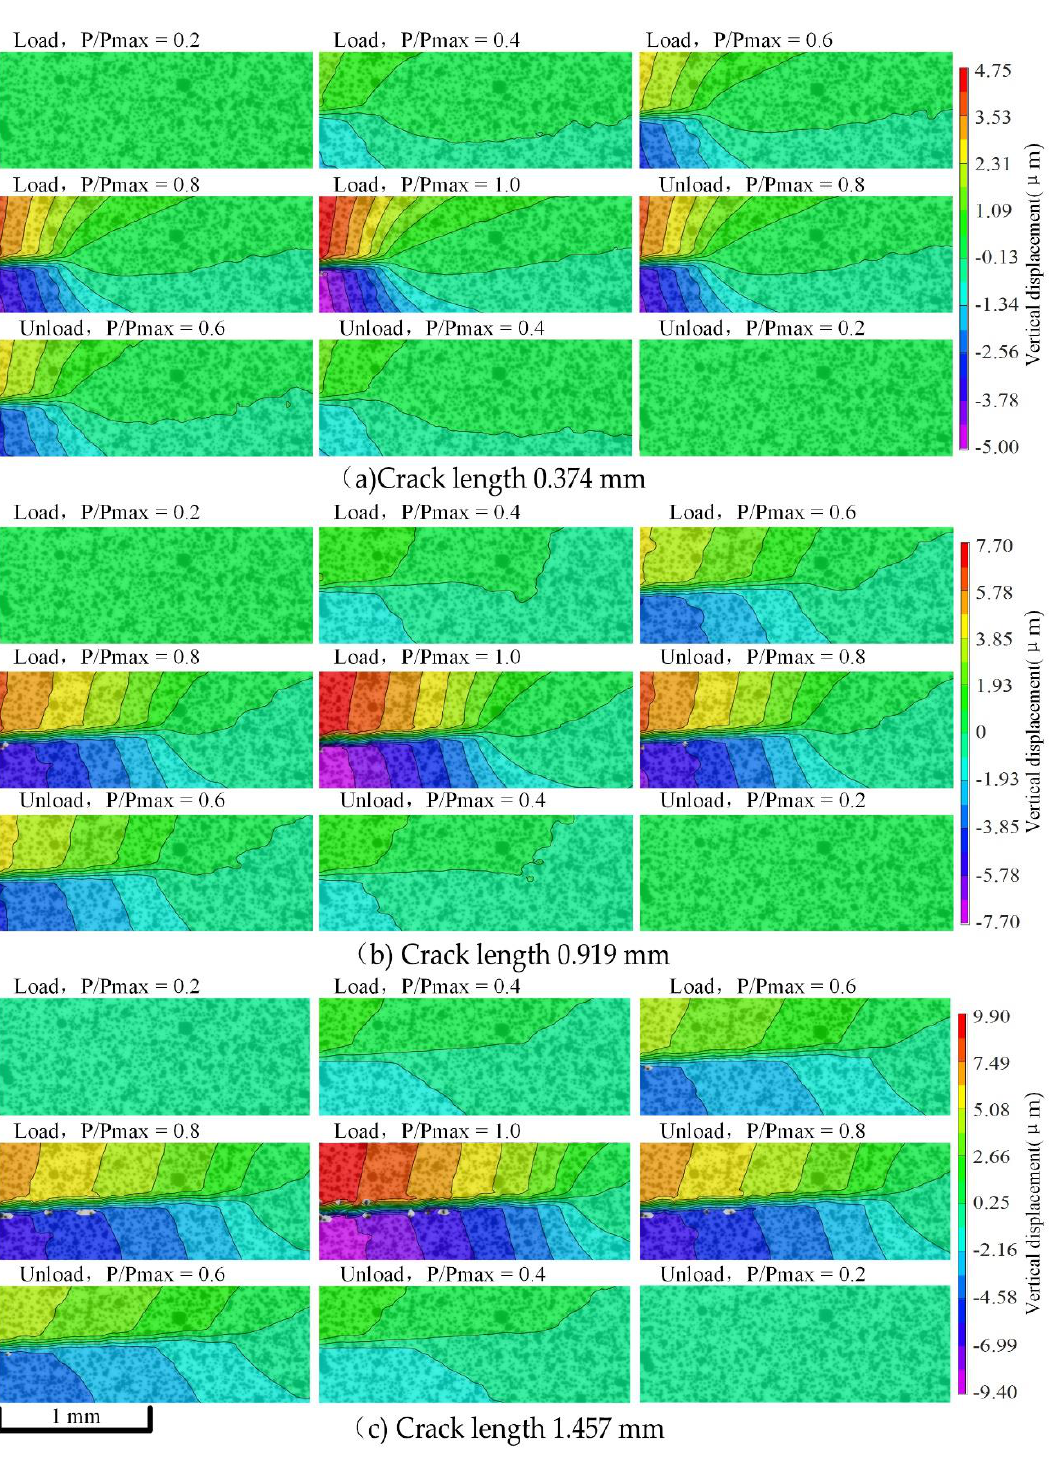
Figure 9. The vertical displacement fields in a load cycle at different crack lengths when the stress ratio is 0.2.